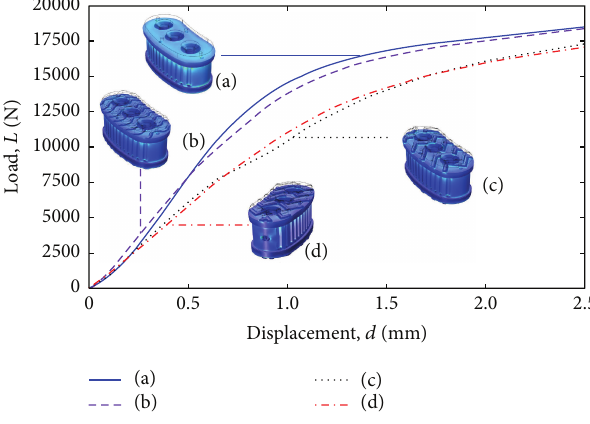
Figure11:Compressiontestingforalldesignconceptswith0.40 mm nozzle configuration.